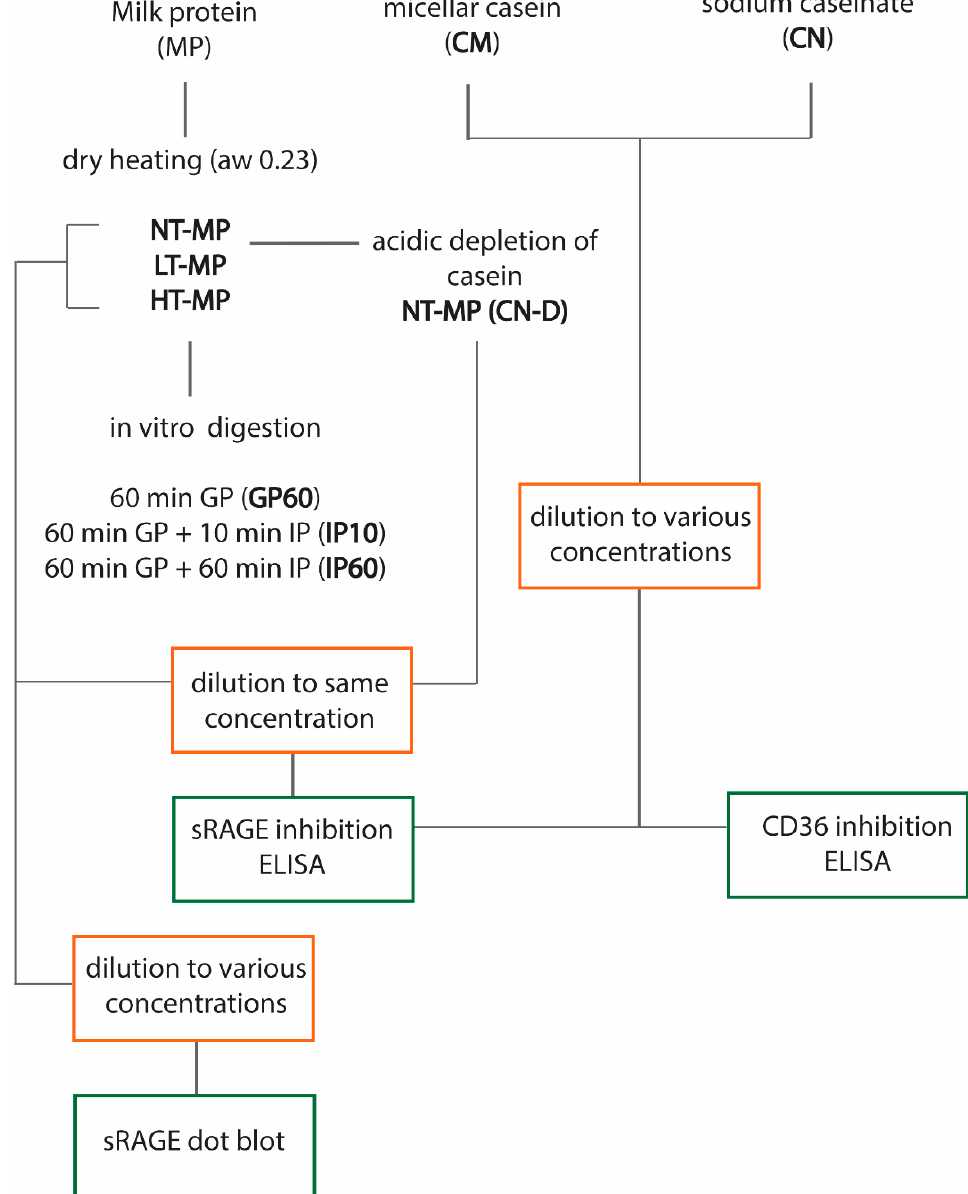
Figure 1. Overview of the experimental design. Non-treated milk protein (NT-MP), low-temperature-heated milk protein (LT-MP), high-temperature-heated milk protein (HT-MP), casein depleted (CN-DP), gastric phase (GP), intestinal phase (IP), water activity (aw), and soluble receptor for advanced glycation end products (sRAGE).